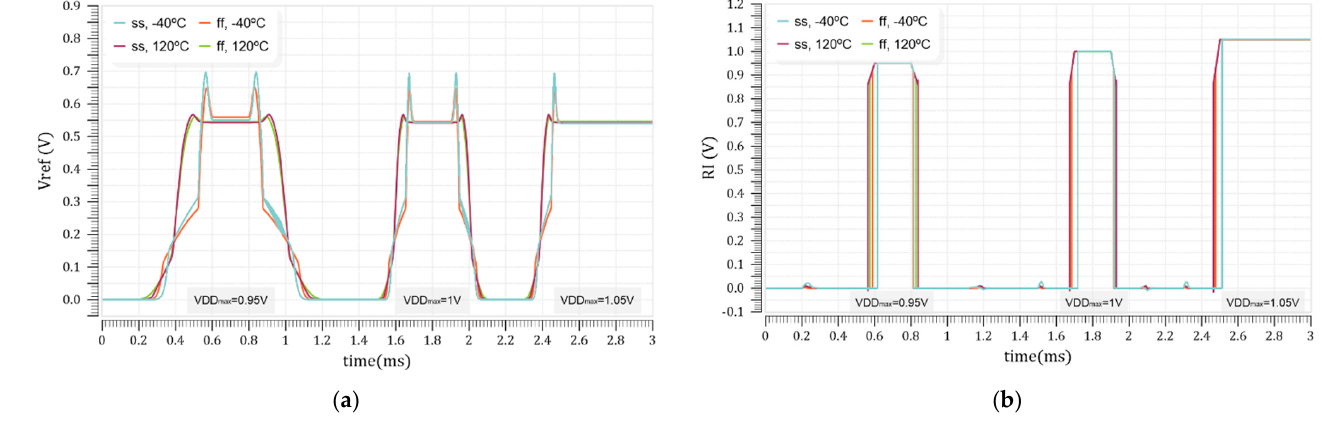
Figure 8. Simulation results for BGR#1 (65 nm, 1 V) in PVT corners. ( a ) Vref , ( b ) RI.